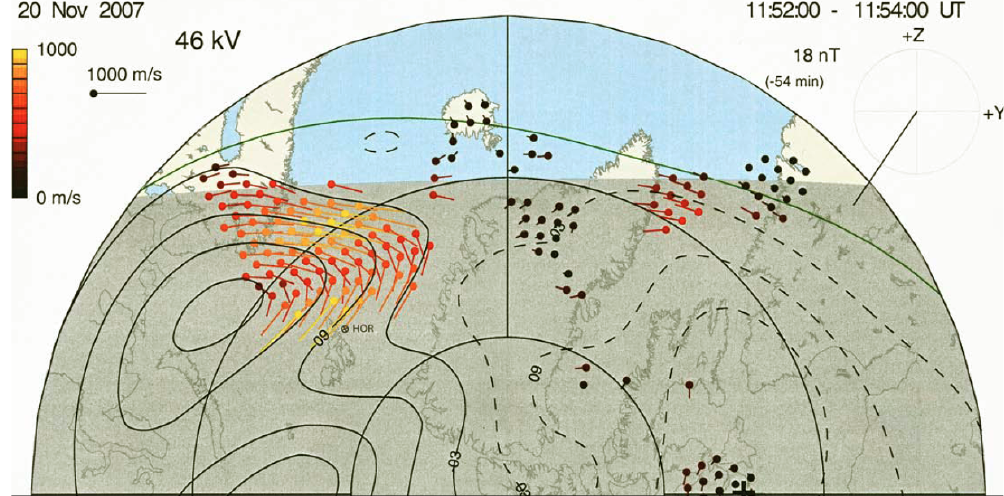
Fig. 17. SuperDARN ion drift data for 11:52–11:54UT, 20 November 2007. Flow channel FC of category FC 2 – NH-dusk/ B y < 0 is seen at 15:00MLT/72–73 ◦ MLAT. The approximate location of the magnetometer station at Hornsund (HOR) has been marked.